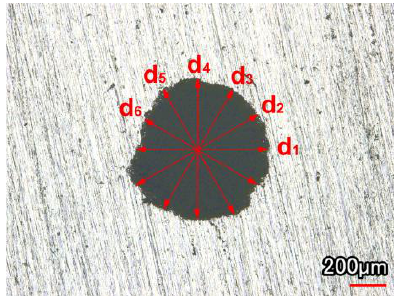
Figure 3. Schematic diagram of diameter measurement.